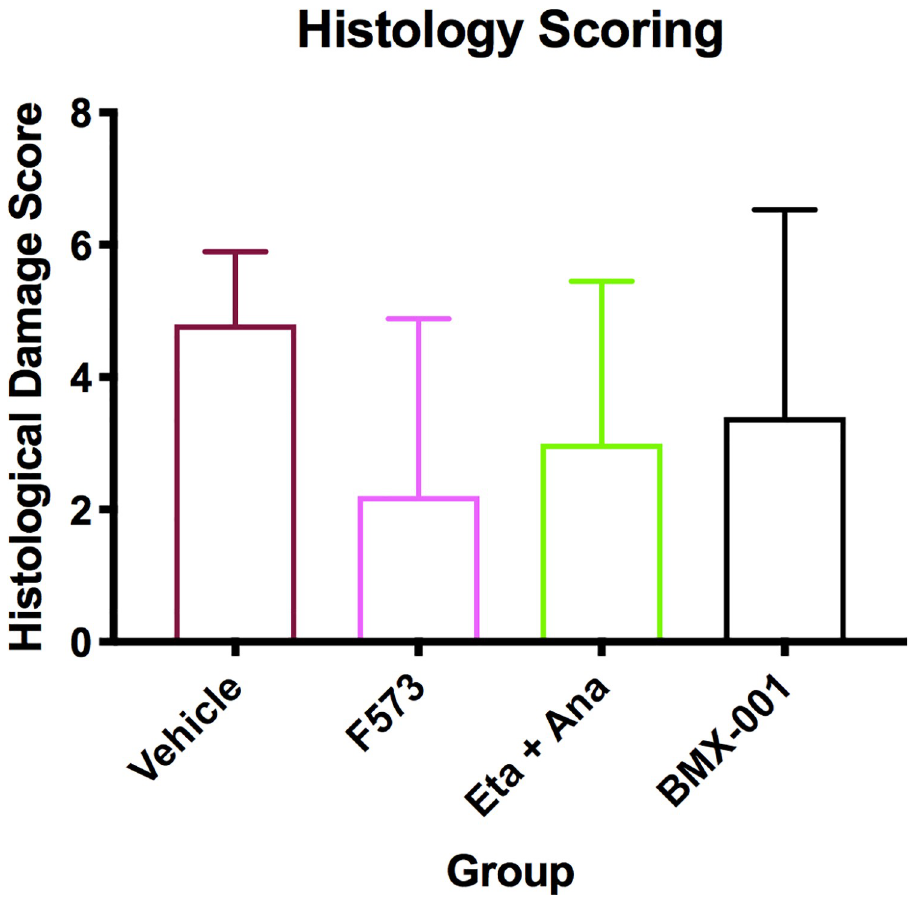
Fig 6. Histological scoring of liver injury. (A) All tissue slides were examined and scored by an independent expert pathologist for hemorrhage, necrosis, sinusoidal dilatation, and bile sequestration. Treated groups all demonstrated less injury, without reaching statistical significance (p = 0.11). Data columns show means and SEM, 95% confidence interval (n = 6 per